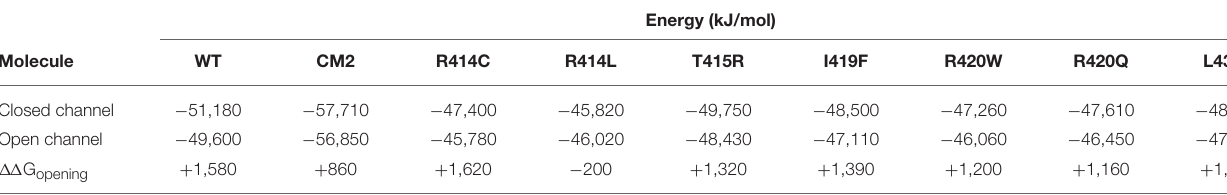
TABLE 6 | Energies of wild type and mutant NTR in the closed and open state.